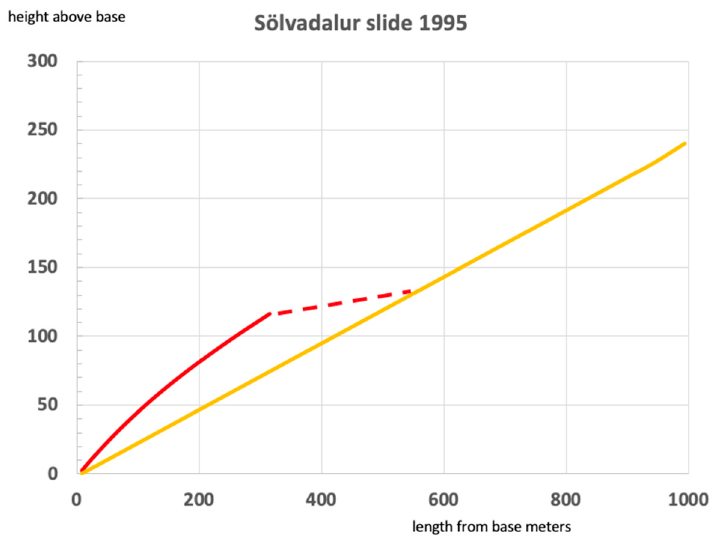
Figure 5. The slide profile, survey of